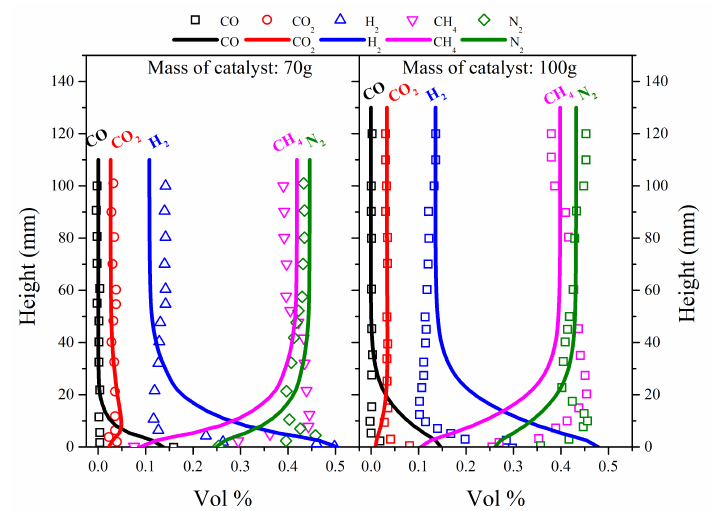
Figure 1. Profile of gas species concentration along height with 70 g and 100 g catalyst. Line: simulated results; scatter: experimental measurement.